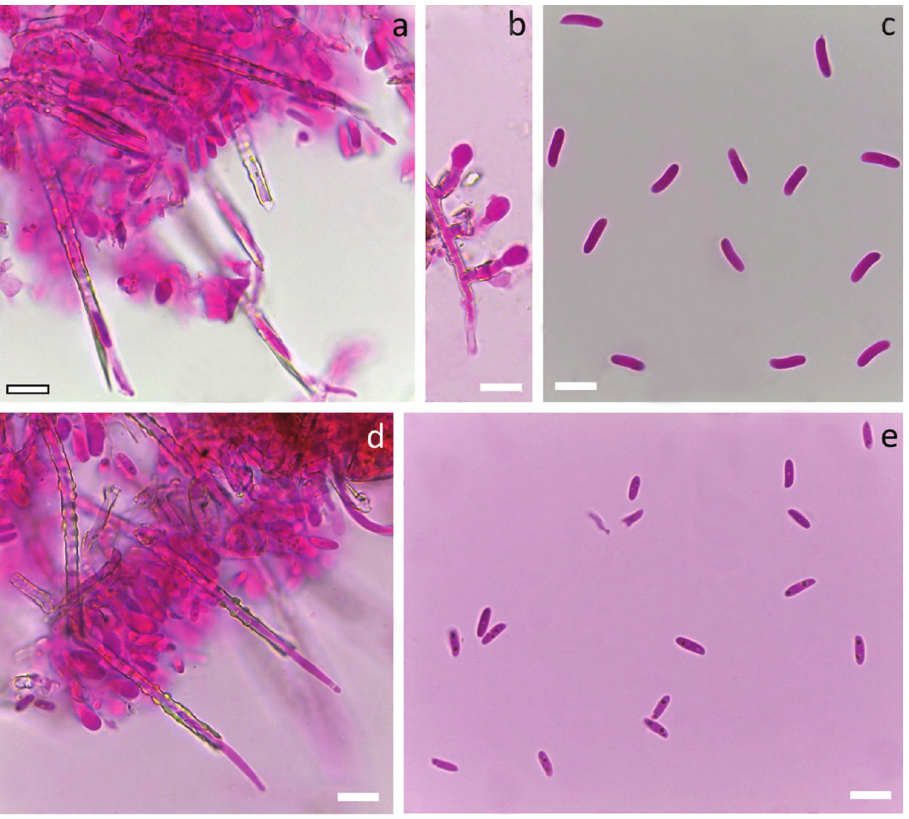
Figure 8. Species of Subulicystidium brachysporum morphotype. Subulicystidium brachysporum sensu Boi- din and Gilles (LR 15784 in O:F 918493): a cystidia in hymenium b crystalline collars on basidioles and slightly encrustated subhymenial hyphae c basidiospores. Subulicystidium brachysporum sensu Talbot (LR 24170 in O:F): d cystidia in hymenium e basidiospores. All preparations done in 3% aqueous solution of potassium hydroxide (KOH) mixed with 1% aqueous solution of Phloxine. All scale bars equal 10